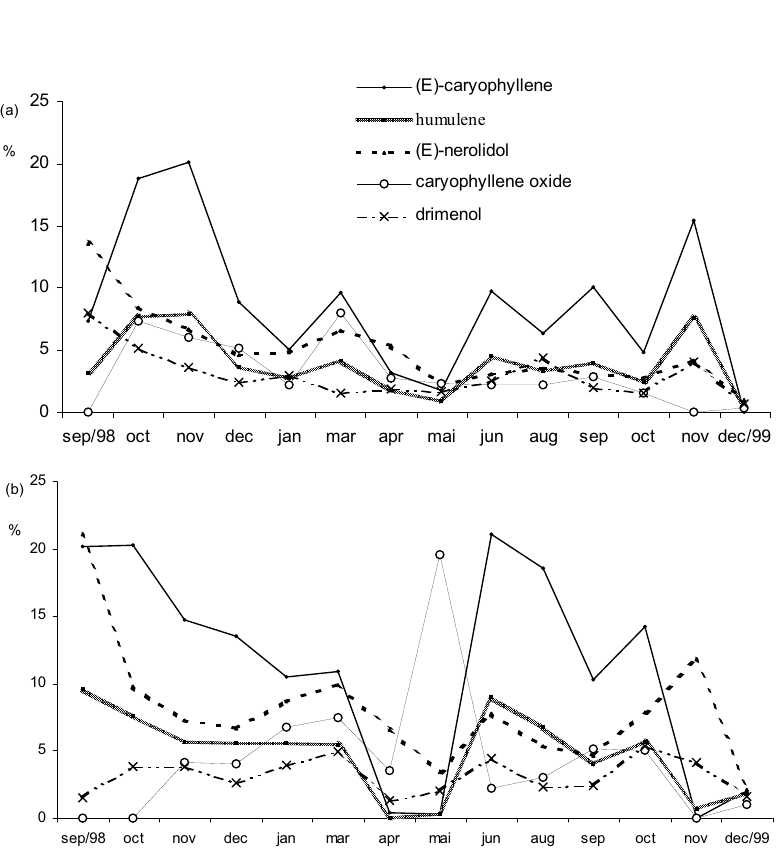
Fig. 1 – Monthly variability of the major sesquiterpene constituents of the E. grandiflorus essential oil from the SL (a) and BL (b) population (% of chromatogram